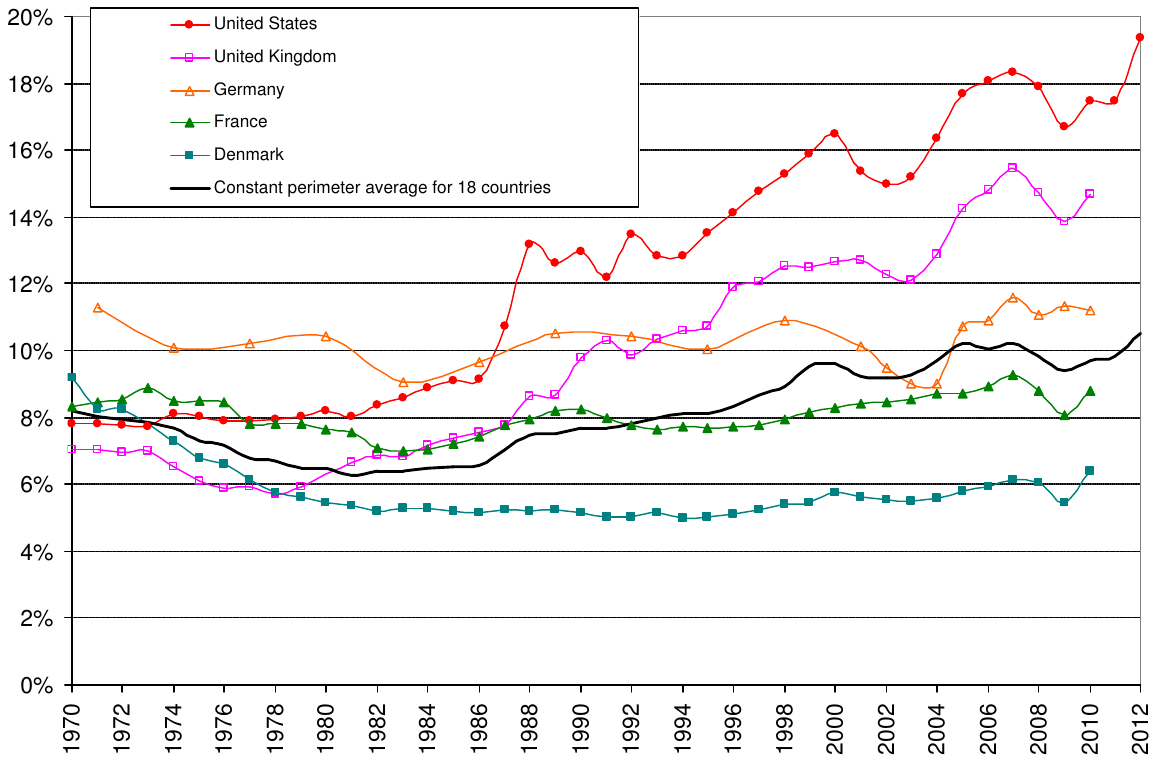
Figure 1: Evolution of the top 1 percent income share. Note: In 2012, the United States’ top 1% earned 19.3% of the national income. The constant perimeter average is a simple 18 countries arithmetic mean that I correct additively when the set of country is not complete in order to avoid disruptions in levels and to measure constant perimeter evolutions. (Cf. Online Supplement, Note on figures and constant perimeter averages for precise